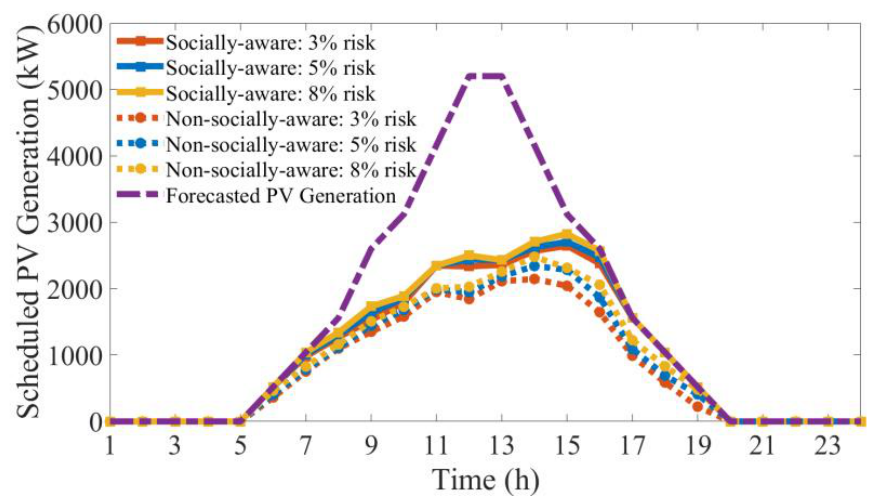
Figure 7. Scheduled PV generation for Case II with PV reserve policy of 10%.